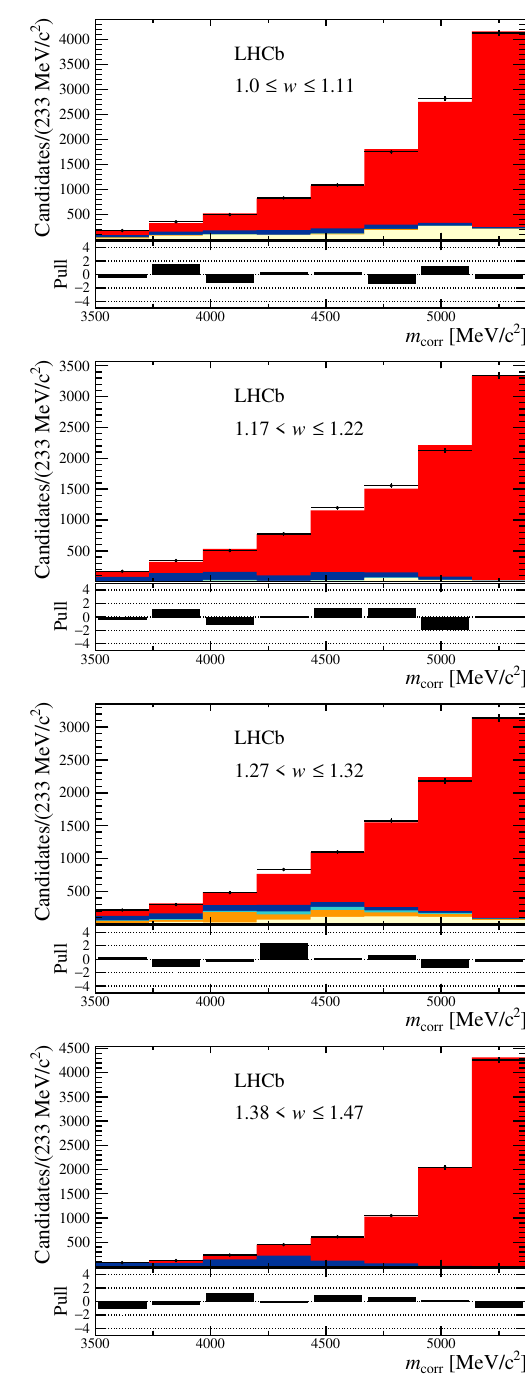
Figure 3 . Distribution of the corrected mass, m corr , for the seven bins of w , overlaid with the fit results. The B 0 → D s 1 (2460) − τ + ν τ and the B 0 → D s 1 (2460) − µ + ν µ components are combined in s s B 0 → D s 1 (2460) − ‘ + ν ‘ . Below each plot, differences between the data and fit are shown, normalised s by the uncertainty in the